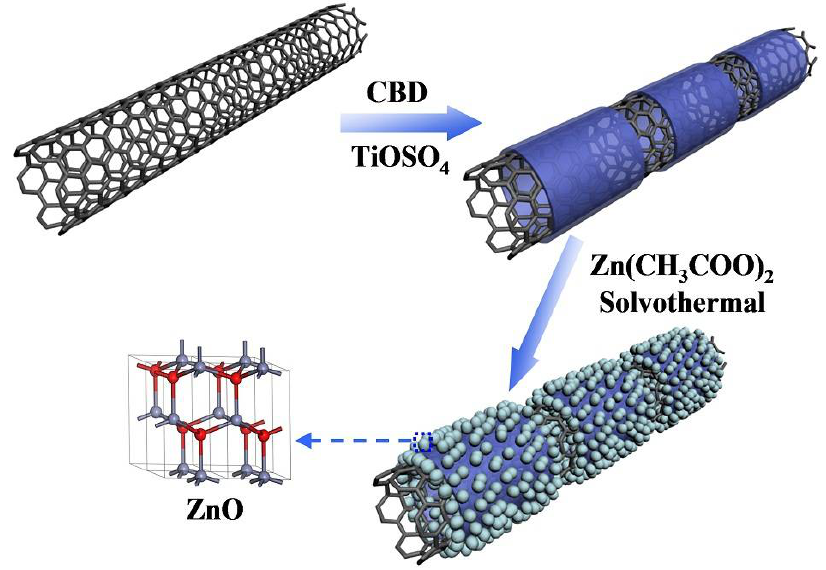
Figure 1. Schematic illustration of the ternary carbon nanotubes (CNTs)/TiO 2 /ZnO composites.